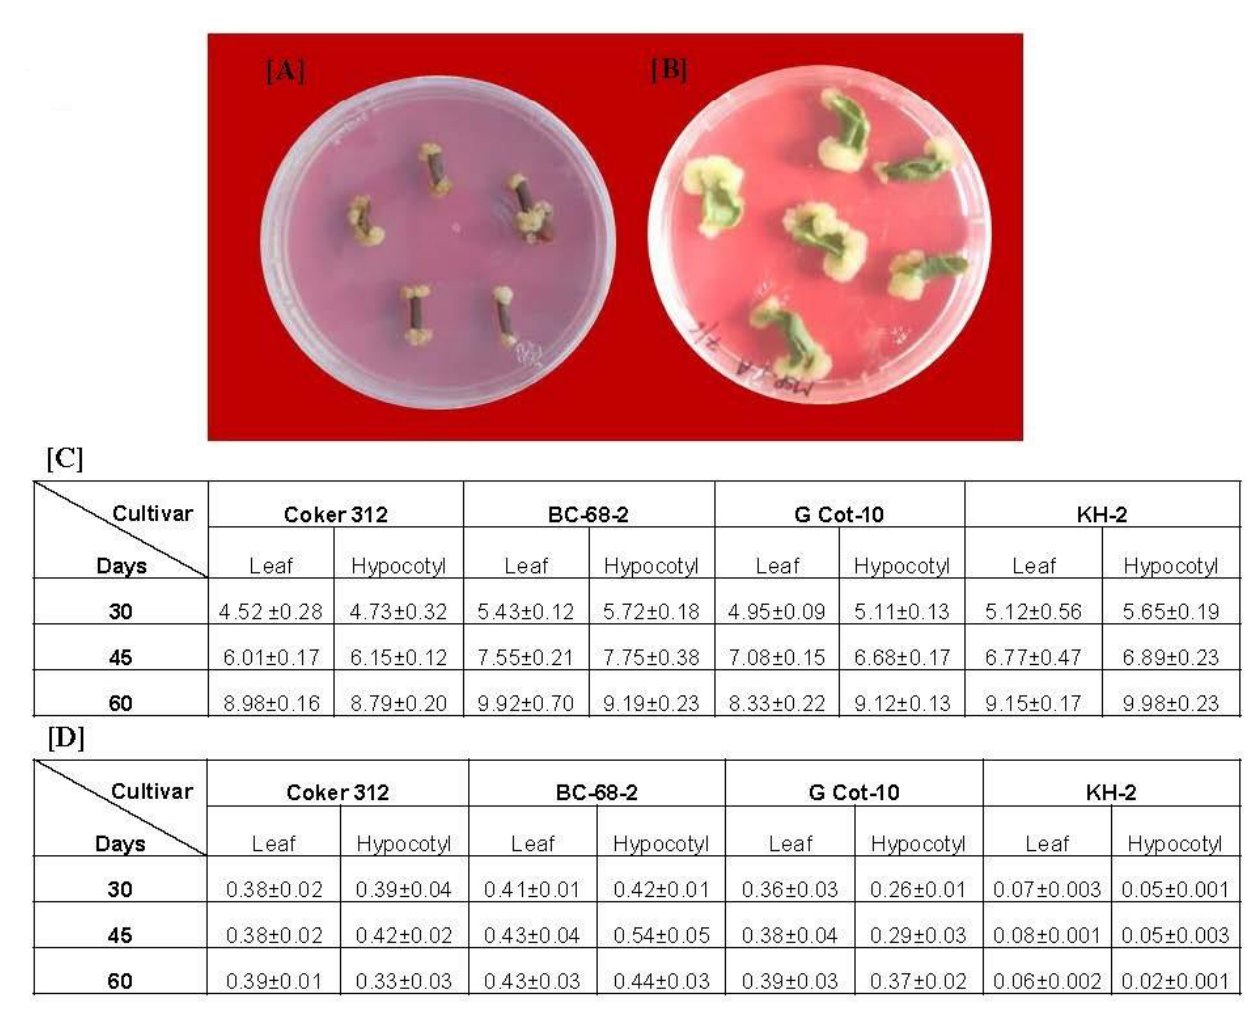
Figure 1. Induction of callus on MS plate: hypocotyl ( A ) and leaf ( B ) explants showing callusing started at the cut ends; ( C ) biomass (fresh weight in grams) of callus from both explants of each cultivar at different time intervals; ( D ) gossypol content (mg/g of dry weight) of callus from both explants of each cultivar at different time intervals.